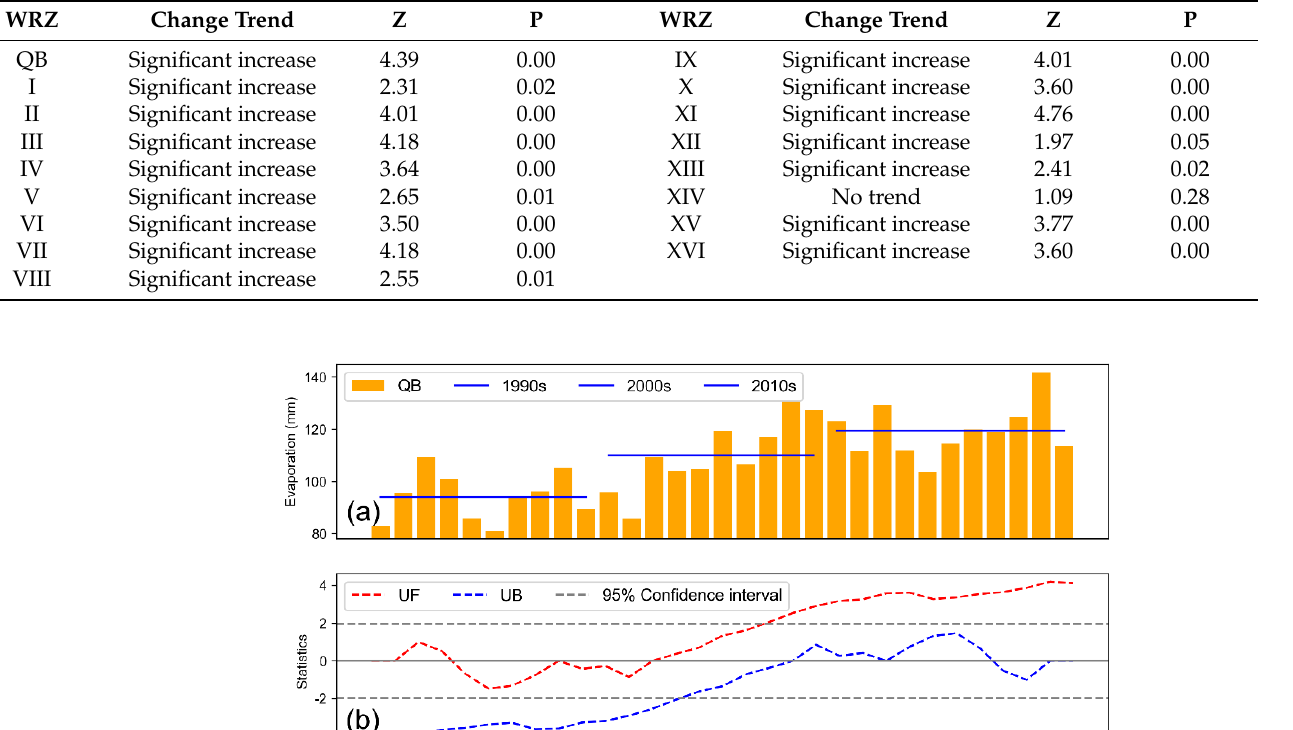
Table 5. Test results of the actual evaporation trend in the Qaidam Basin from 1990 to 2020.